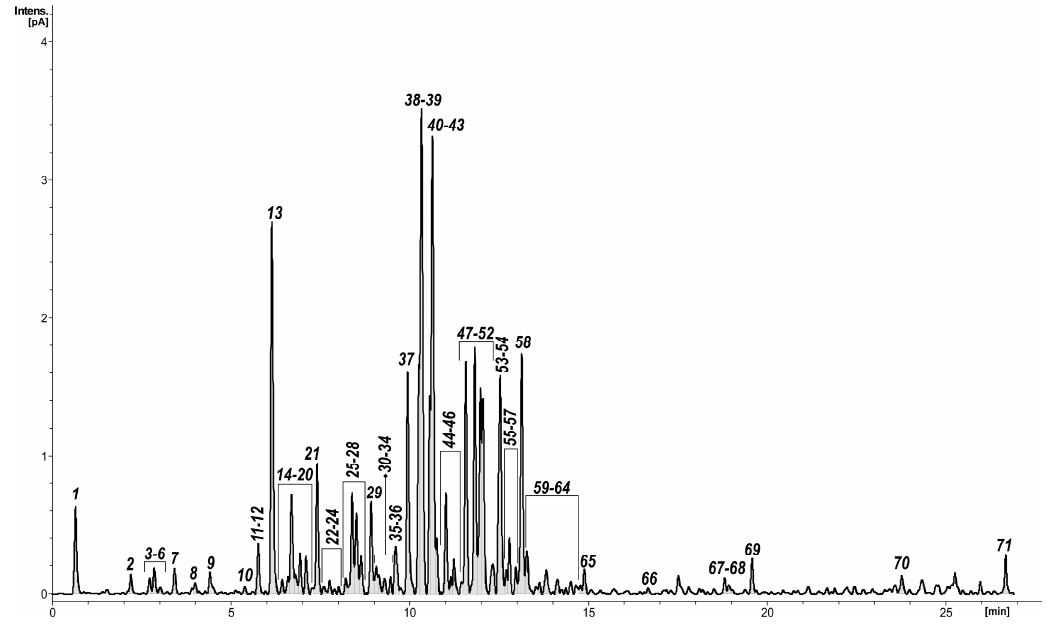
Figure 1. Ultra-high-performance liquid chromatography–charged aerosol detector (UHPLC-CAD) profile of the Yucca schidigera ethyl acetate fraction.